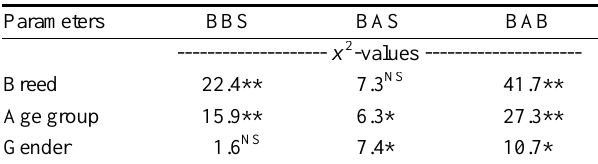
Table 2. Effects of age group, breed and gender on animal behaviour before, after stunning, and during bleeding